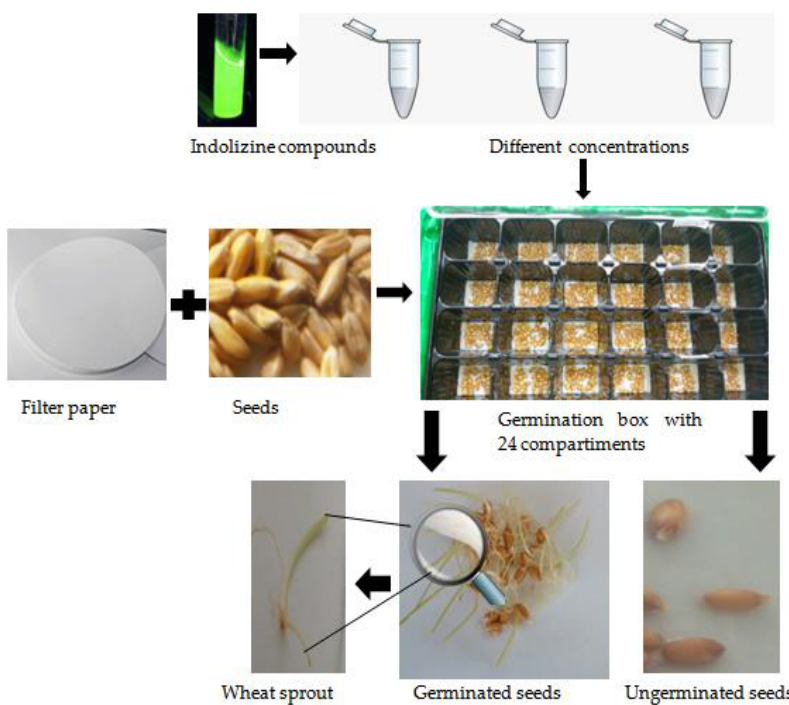
Figure 10. Phytotoxic analysis of the germination of wheat seeds exposed to indolizines compounds at different concentrations.